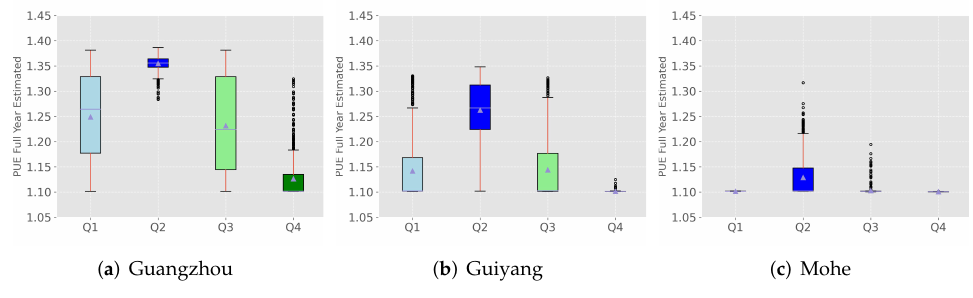
Figure 4. Annual PUE estimation in 3